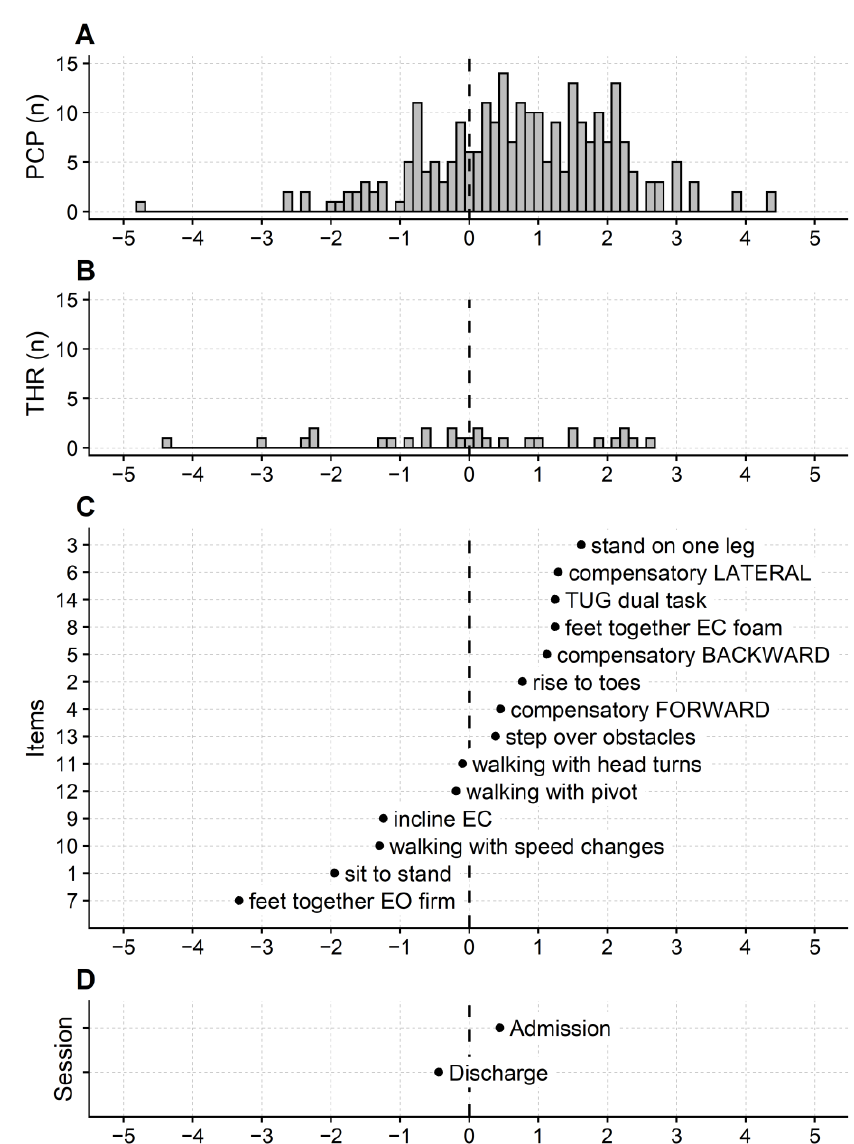
Figure 2. Maps of the Mini-BESTest scale. ( A ) distribution frequency of the patients’ measures. ( B ) distribution frequency of the Andrich thresholds. ( C ) item calibrations. ( D ) session calibrations (admission vs. discharge). Participants, items (with the Andrich thresholds), and sessions are the first, second, and third facets of the Many-Facet Rating Scale model used for the Rasch analysis. PCP: participants; THR: thresholds; n: number of. Item content is abbreviated with a keyword, and the ordinate gives the item number in the questionnaire. Items are ordered from low to high, from the easiest balance task to the most difficult to complete.